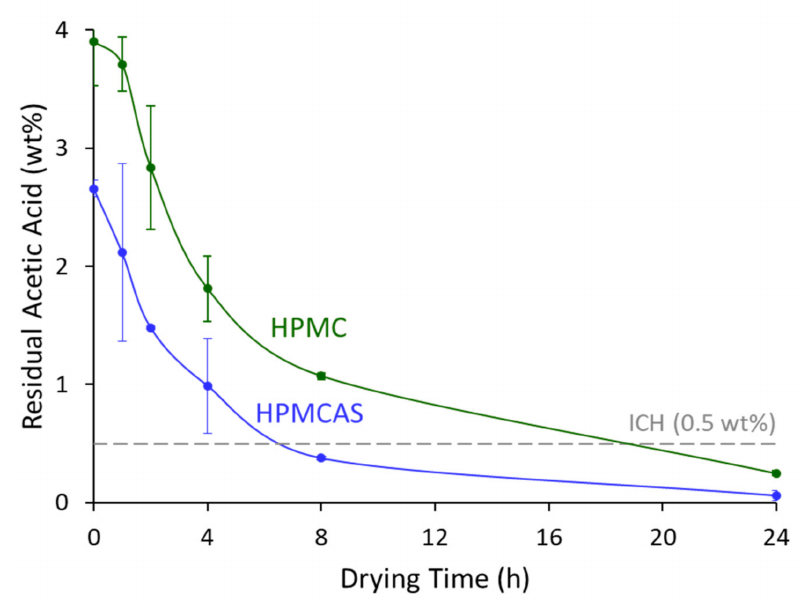
Figure 3. Acetic acid drying curves of the GEF SDDs of HPMC (green) and HPMCAS (blue) dried at 40 ◦ C/15%